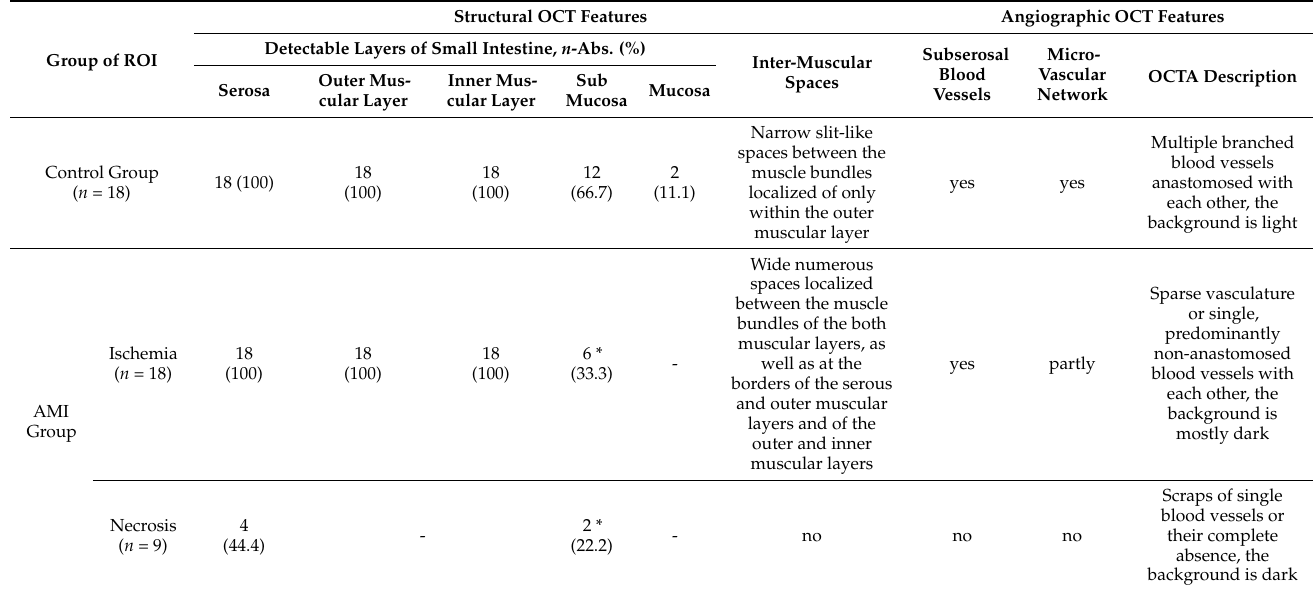
Table 3. Characteristics of MM OCT features of the small intestine in studied groups of patients. n -number of regions of interest